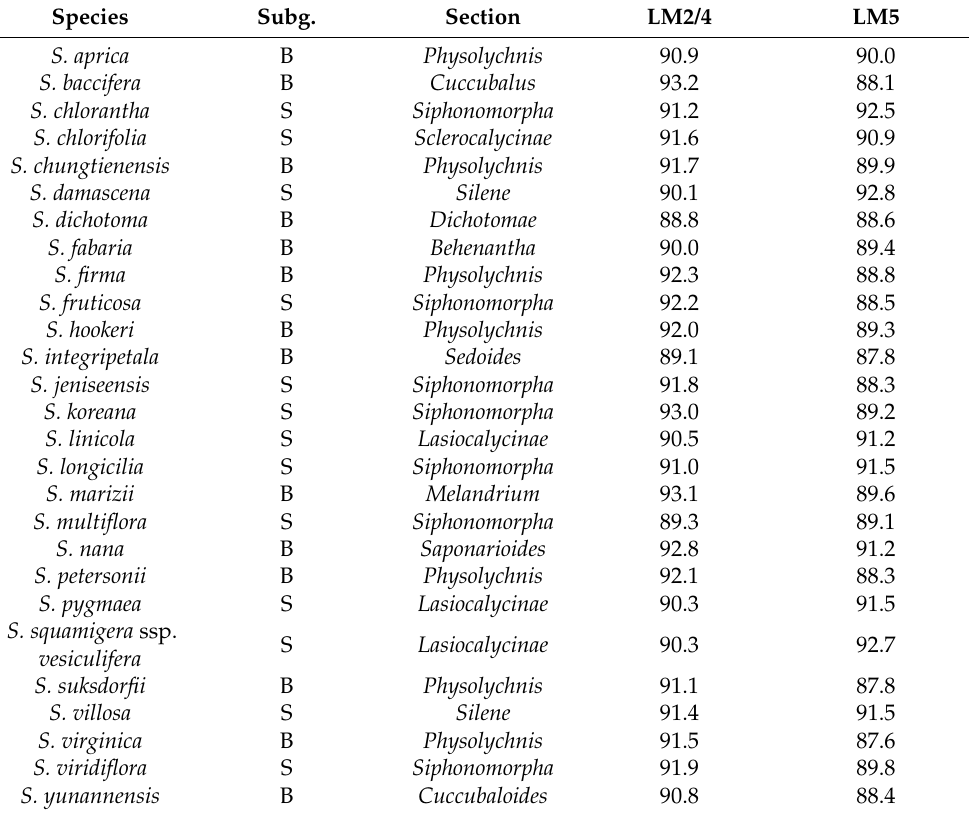
Table A7. Data used in the construction of the dendrogram in Figure 21. In column 2, subg., B stands for Behenantha ; S for Silene